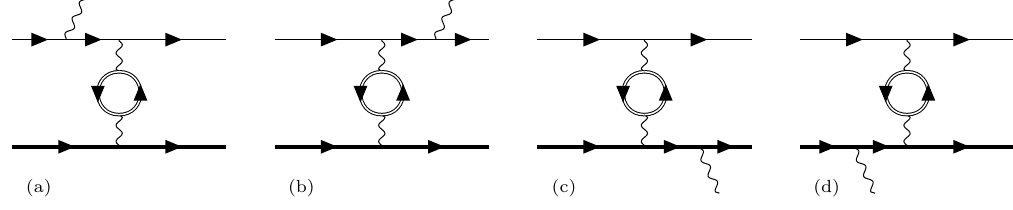
Figure 7. NNLO real photon radiation diagrams. Radiation from the electron line (a)–(b) and from the muon line (c)–(d).